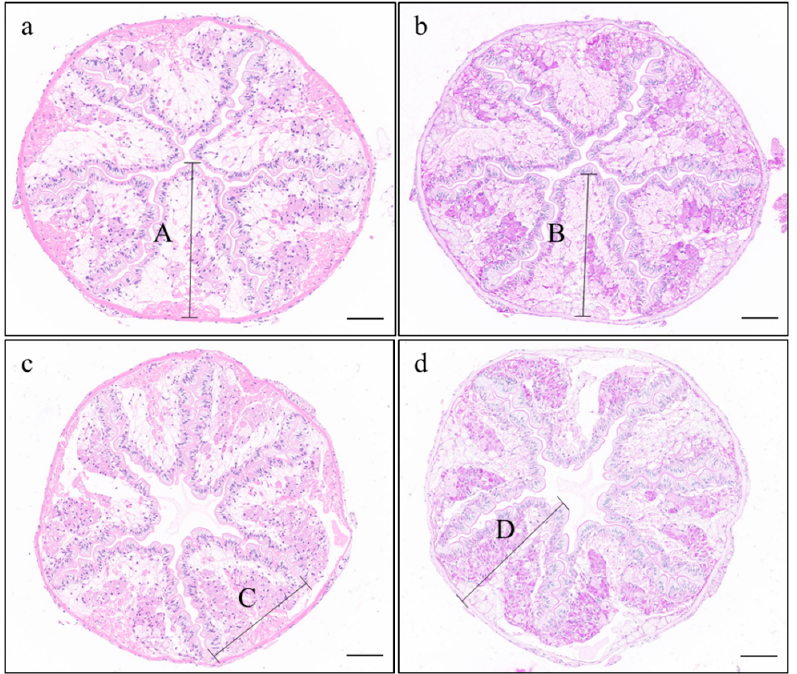
Figure 1. Histological sections of the intestine of P. clarkii . ( a ) pelleted feed group, H&E stain (10 × ); ( b ) pelleted feed group, PAS stain (10 × ); ( c ) extruded feed group, H&E stain (10 × ); ( d ) extruded feed group, PAS stain (10 × ). Scale bar: 100 µ m. Uppercase letters indicate examples of measurements of villus height, mucosal fold width, lamina propria thickness and intestinal wall thickness (A, B, C and D, respectively).